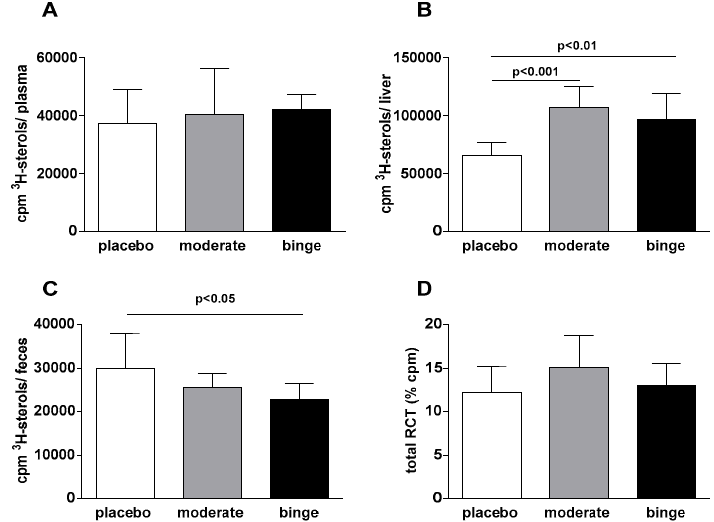
Figure 1. Effects of moderate and binge alcohol consumption on macrophage reverse cholesterol transport (RCT) in vivo. Apo E − / − (B6.129P2-apoE tm1Unc/Crl ) mice were treated with alcohol for 28 days as described in the Methods Section. On day 26 of treatment, animals were intraperitoneally injected with [ 3 H]-cholesterol loaded murine peritoneal macrophages. After 48 h, mice were sacrificed and macrophage-derived [ 3 H]-cholesterol distribution was quantified in plasma ( A ), liver ( B ), and feces ( C ). Total RCT was calculated as the sum of radioactivity detected in plasma, liver, and feces and expressed as percentage of [ 3 H] dose injected ( D ). Results are expressed as mean ± SD ( n = 9–10 mice per group) and were analyzed using one-way ANOVA followed by Tukey’s multiple comparison test among